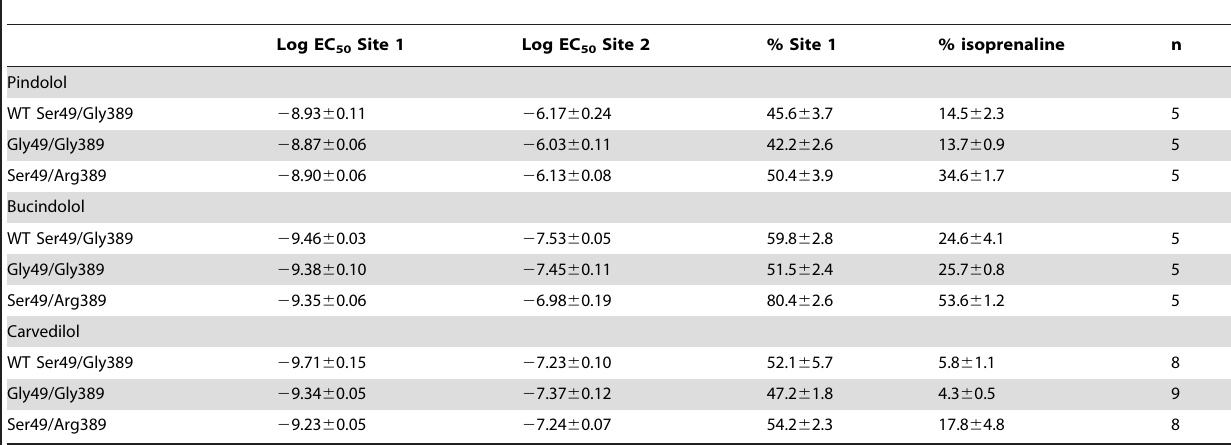
Table 4. Agonist responses for ligands with biphasic responses at the wildtype and polymorphic variants of the b